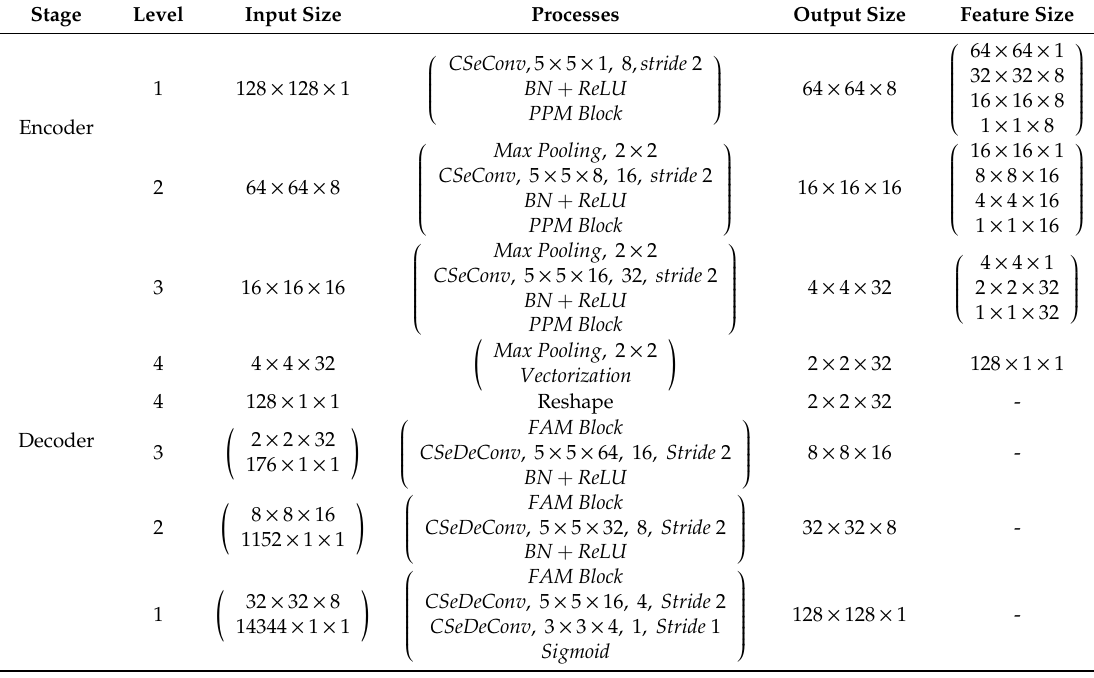
Table 3. The main structure of the MSCAE with four modality levels utilized in the experiments. Stage Level Input Size Processes Output Size Feature Size